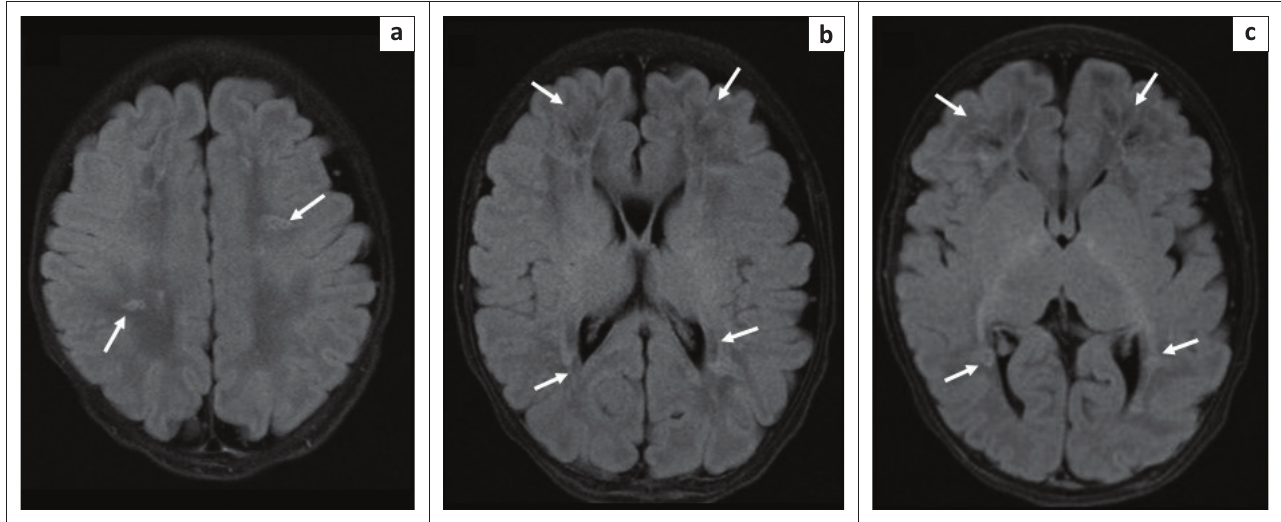
FIGURE 3: Axial fluid-attenuated inversion recovery MRI of the brain (inversion time 2500, repetition time msec/echo time msec, 9000/112, 3-mm section thickness) at the level of the high frontal lobes (a), basal ganglia (b) and peritrigonal white matter (c). Images demonstrate areas of FLAIR signal abnormality involving the corpus callosum and the bilateral supratentorial white matter, predominantly the bilateral frontal regions (solid white arrows on all images) with sparing of the thalami.